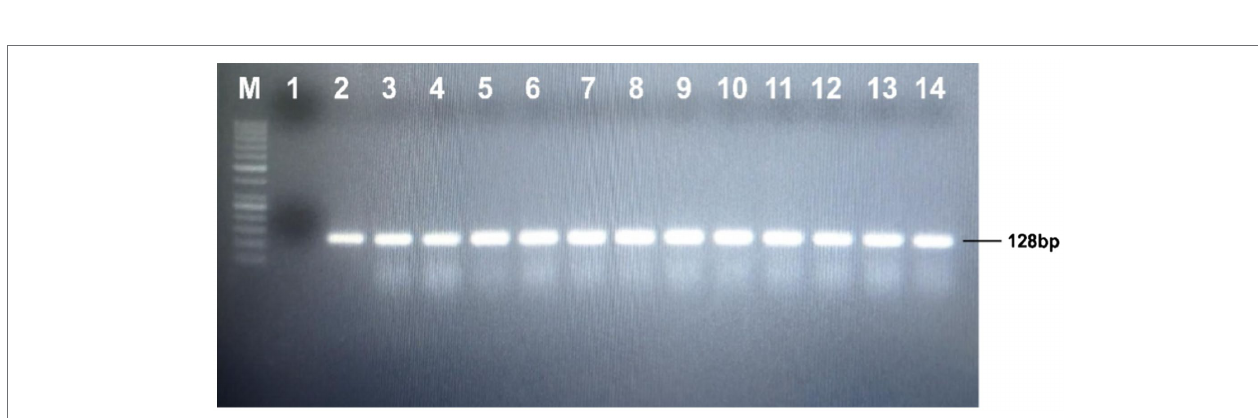
FIGURE 7 | Detection of the transgene into putative transgenic cotton line through PCR; Lane M: 1 kb molecular weight marker; Lane 1: negative control; Lane 2: positive control; Lanes 3–14: putative transgenic cotton